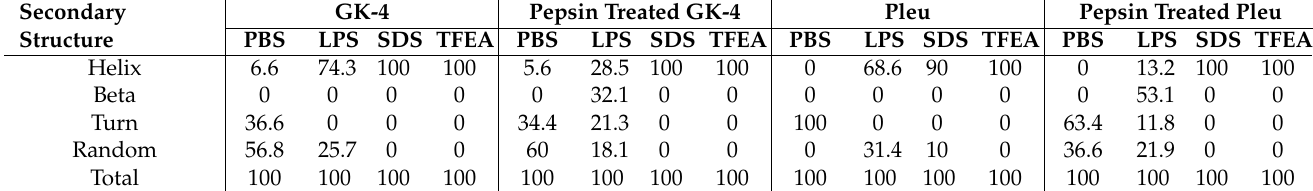
Table 4. Secondary structures of GK-4 and Pleu before and after 1 mg/mL pepsin